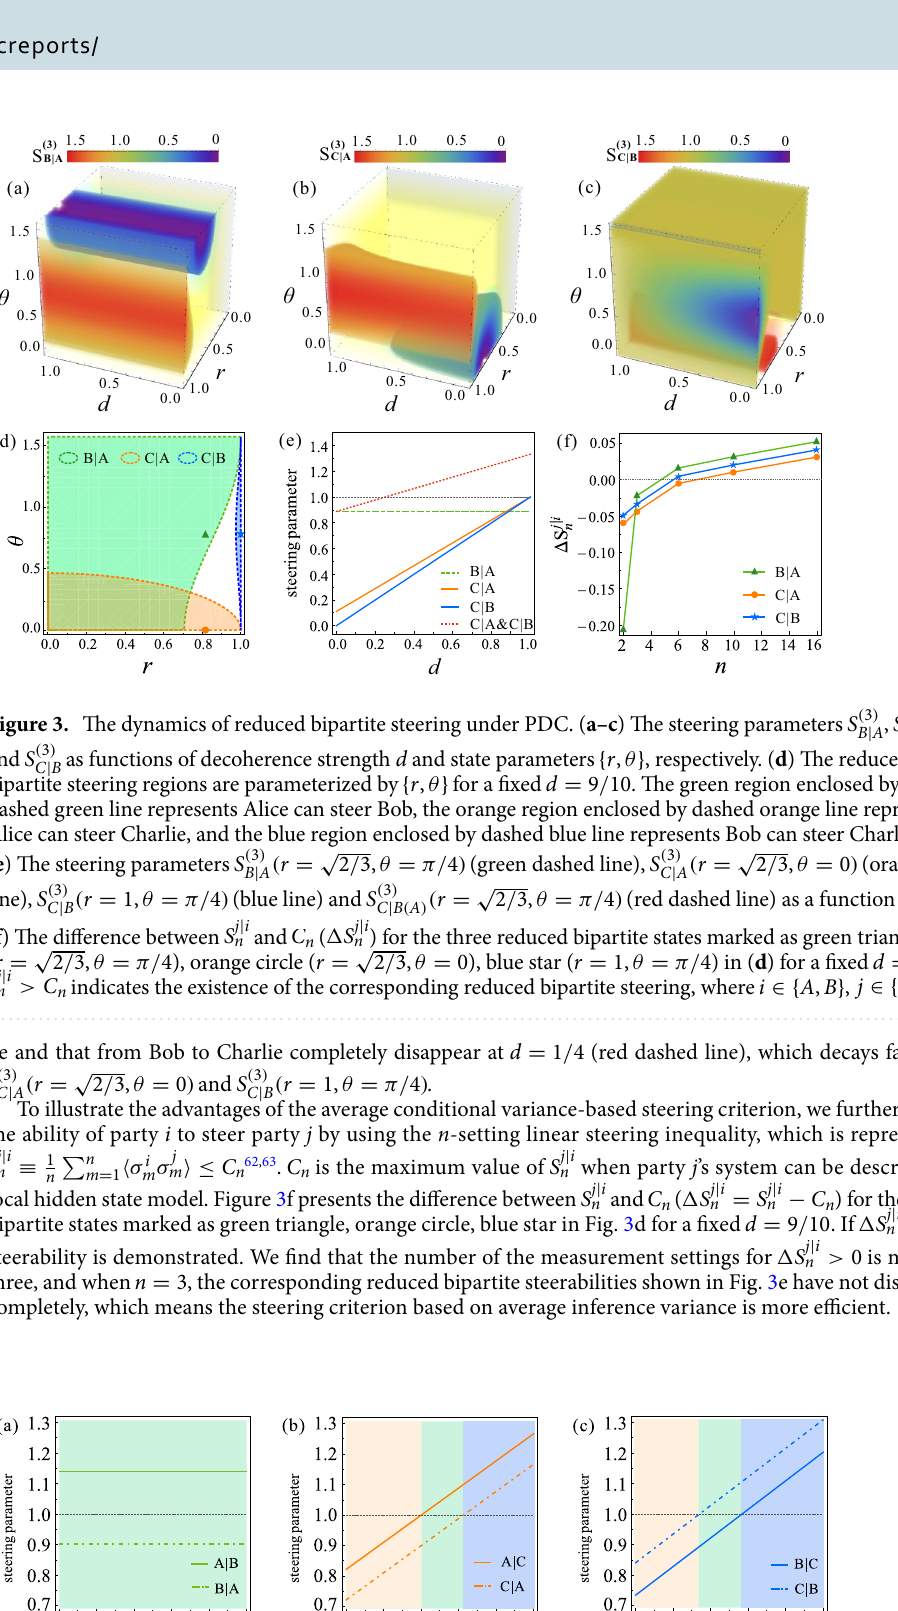
1 / √ 3 , θ π/ 4 vs d . ( c ) The = =